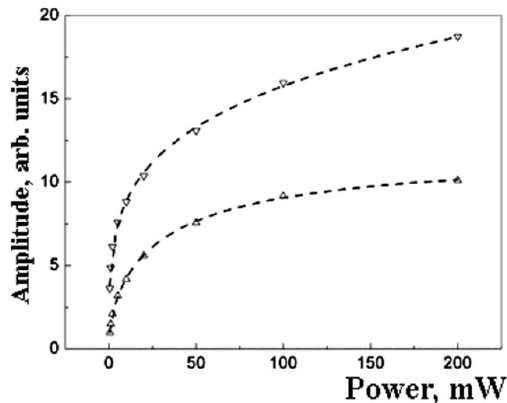
Figure 7. The amplitude saturation curves for the two Lorentzians presented at Figure 6. The dot lines show approximation by formulae (3). The upper line has the following parameters: P 0 . 5 = 0.3 ± 0.2 ; b = 0.50 ± 0.02. The bottom line has P 0 . 5 = 60 ± 15; b = 1.0 ± 0.1.